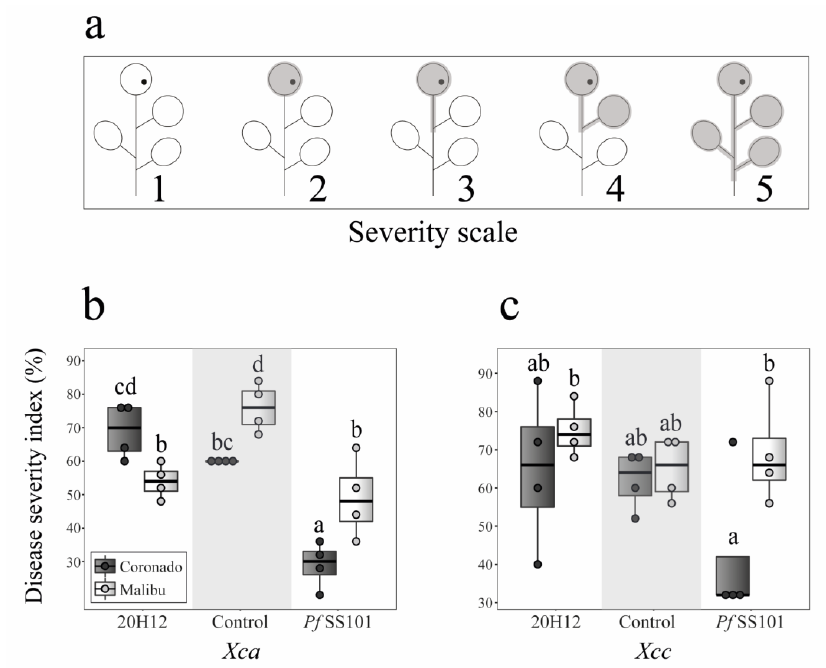
Figure 2. Rhizobacteria-mediated systemic resistance in two Broccoli cultivars, Coronado and Malibu, against the bacterial leaf pathogens. Disease severity was scored on an ordinal scale from 0 to 5, where 1 = no necrosis or migration, 2 = full infection of the treated leaf, 3 = migration of the infection to the leafstalk of the treated leaf, 4 = infection of the neighboring leaf, and 5 = infection of the entire seedling ( a ) (see Supplementary Materials Figure S1 for further details). Details on the conversion of the ordinal scales to disease severity index is provided in the Material and Methods section. Impact of priming roots of Broccoli cultivars with rhizobacteria on severity of leaf disease caused by Xanthomonas campestris pv. armoraciae ( Xca ) ( b ) and Xanthomonas campestris pv. campestris ( Xcc ) ( c ). Prior to pathogen inoculation on the leaves, roots of each Broccoli cultivar were treated with P. fluorescens SS101 or its cysH -mutant 20H12 and incubated for 11 days. For the disease severity caused by Xca or Xcc , Broccoli seedlings from four biological replicates were individually scored ( n = 20). Different letters above bars indicate statistically significant differences based on beta regression analysis followed by Tukey test ( p <